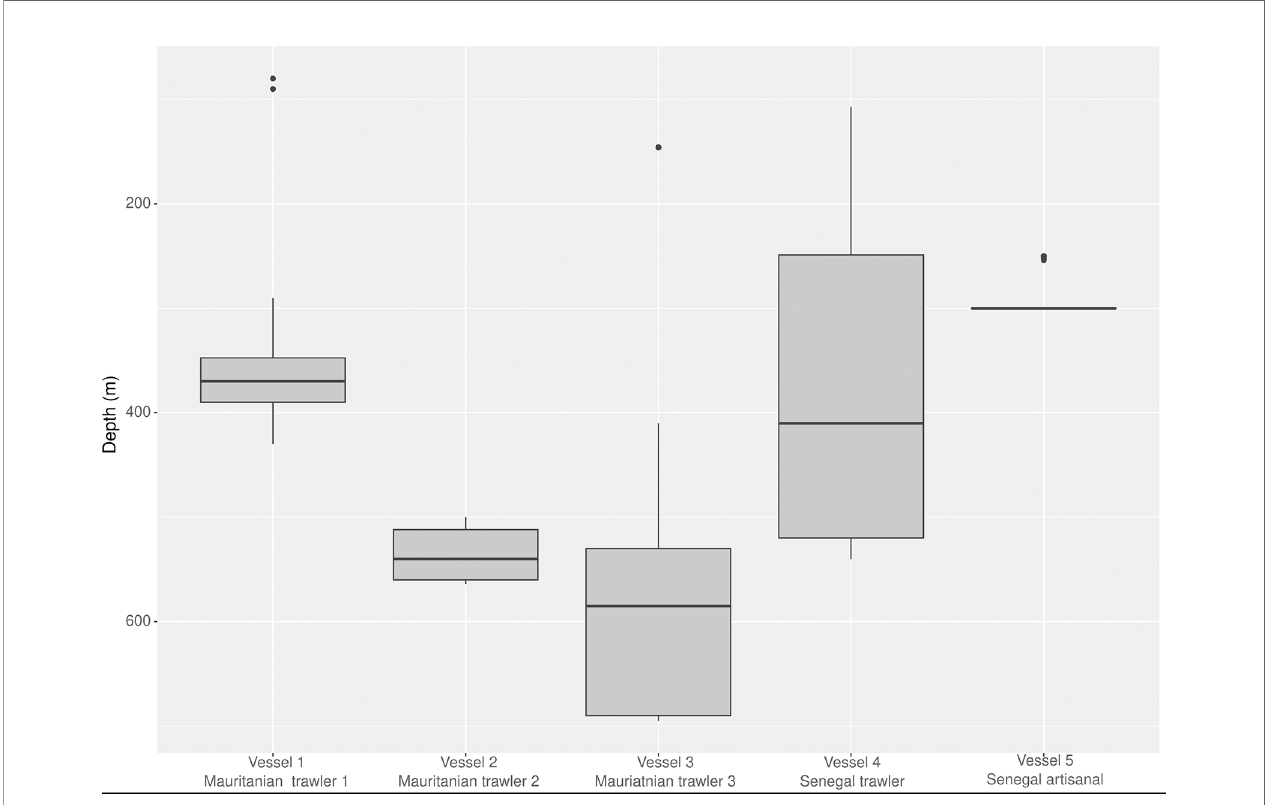
FIGURE 2 | Boxplots showing the distribution of the depth of the catches (in meters) for the different